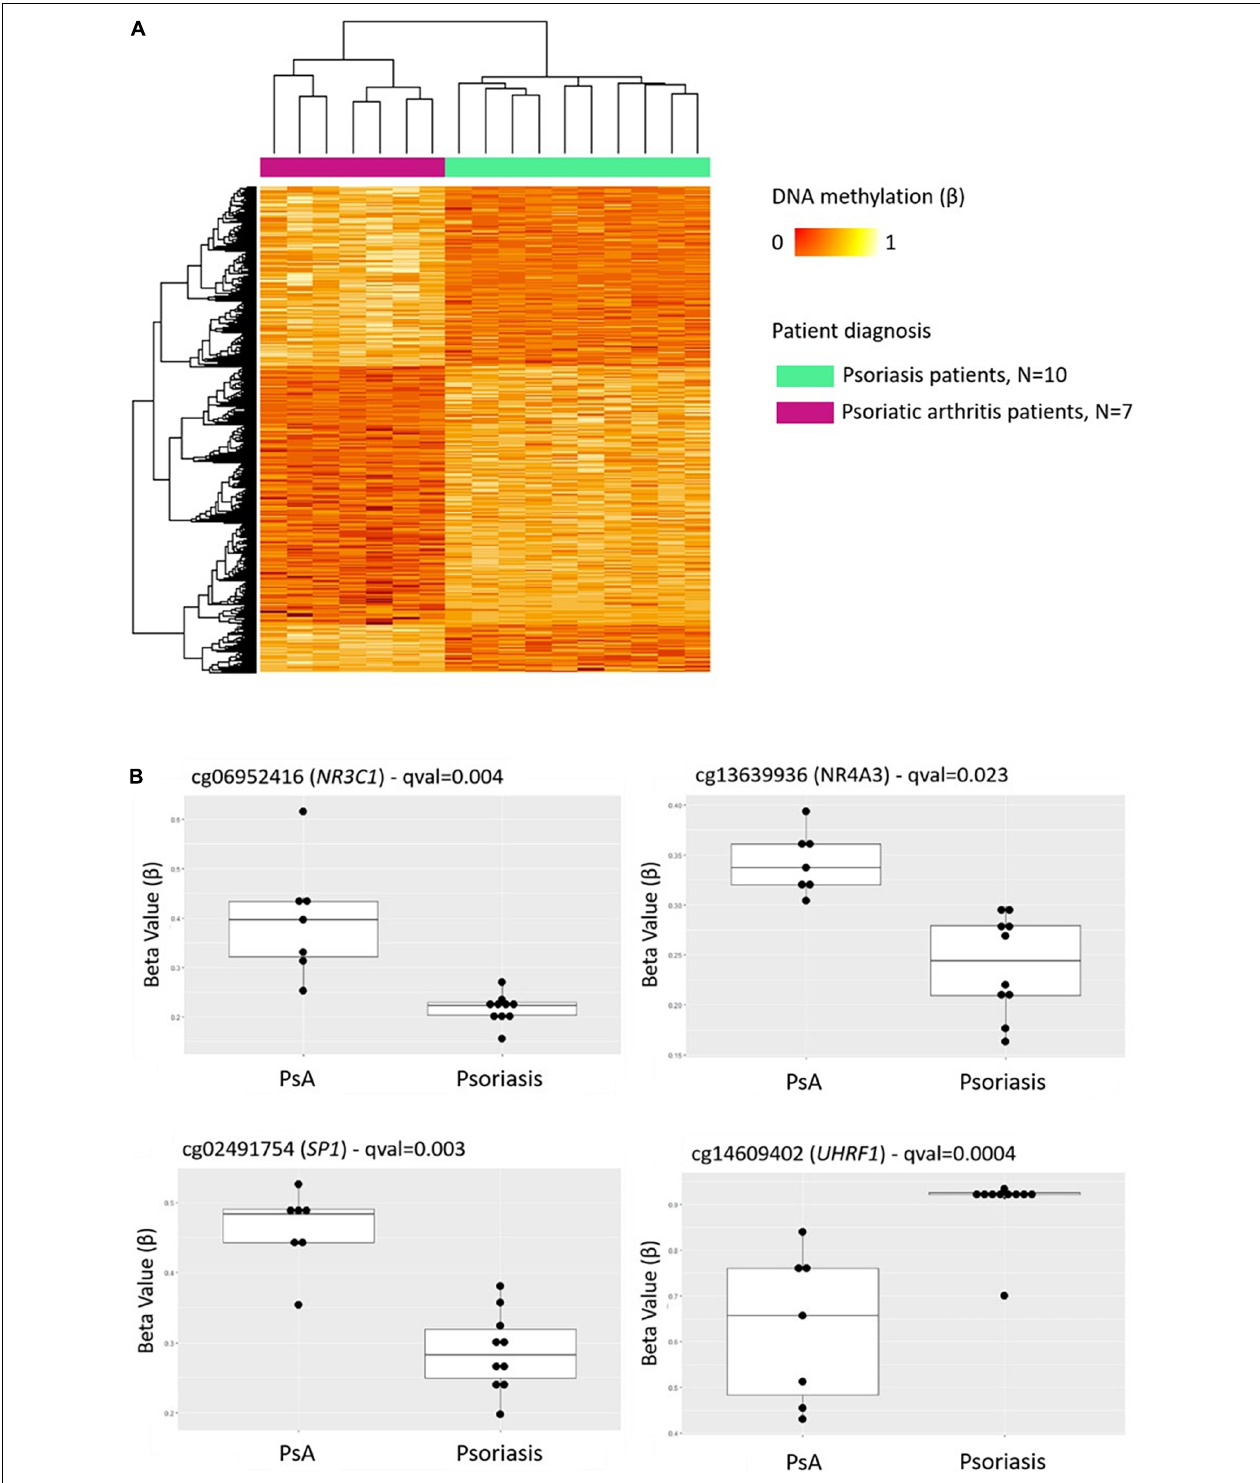
FIGURE 2 | DNA methylation profiles differentiate CD8 + T cells from psoriatic arthritis and skin psoriasis patients. (A) Heat map showing differentially methylated positions (DMP) between psoriatic arthritis patients and psoriasis patients (FDR < 0.05, | (cid:49) β | > 0.1). Normalized DNA methylation levels are displayed on the right with red indicating reduced methylation and yellow indicating increased methylation levels. (B) Differences in beta values of selected CpG sites identified as DMPs across psoriasis and psoriatic arthritis patients. PsA, Psoriatic arthritis patient.